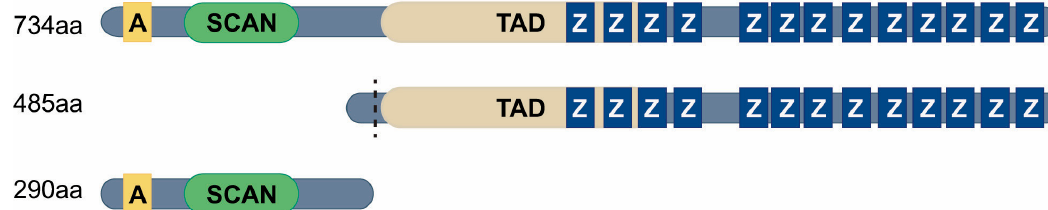
Figure 1. MZF1 protein isoforms. Top: Domain structure of the full-length (734 amino acid) MZF1 isoform containing five distinct domains: acidic domain (A), SCAN domain (SCAN), transactivation domain (TAD), and 13 highly conserved Krüppel-like zinc finger motifs (Z) arranged in two domains. Middle: Domain structure of the putative (485 amino acid) “zinc finger only”-form of MZF1, that in addition to 13 zinc fingers also has the TAD domain. The amino terminus of the new, recently identified 450 kD zinc finger only isoform is marked with a dashed black line. Bottom: Domain structure of the 290 amino acids “SCAN domain only” form of MZF1 that in addition to the SCAN domain also has the acidic domain (A).